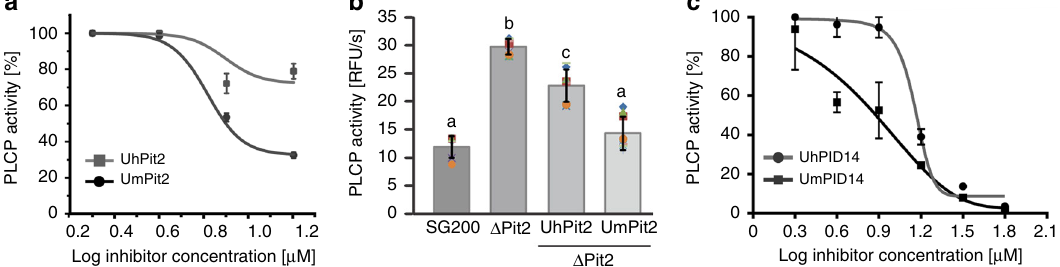
M]1.20.90.60.30SG200 Δ Pit2 M]0.6 0.80.40.2 2.11.81.5 Log inhibitor concentration [ μ Fig. 3 Inhibition of maize PLCPs by U. maydis and U. hordei Pit2/PID14. The activity of PLCPs in apoplastic fl uids of maize leaves treated with salicylic acid (SA) was determined using the fl uorogenic substrate Z-Phe-Arg-AMC. a Concentration range of inhibition using heterologous expressed UmPit2 and UhPit2 proteins. Activity was set to 100% in the absence of inhibitor. Curves were generated using a nonlinear fi t and error bars are SEM of three independent replicates. b Activity of apoplastic PLCPs during infection. Apoplastic fl uids of maize seedlings infected with U. maydis SG200, Δ Pit2 and the complemented Δ Pit2-UhPit2 and Δ Pit2-UmPit2 were collected 3 dpi and protein quanti fi cation was performed. Apoplastic fl uids were set to a concentration of 57 µ g/ml total protein and PLCP activity was measured using the fl uorogenic substrate Z-Phe-Arg-AMC. Values are means of three independent biological replicates with at least three technical replicates each (dots) and the error bars represent the standard deviation (SD). Letters above error bars indicate signi fi cant differences between samples ( α = 0.05, Tukey test). c Concentration range of UmPID14 and UhPID14 peptides was performed. Activity was set to 100% in the absence of inhibitor. Curves were generated using a nonlinear fi t and error bars are SEM of three independent